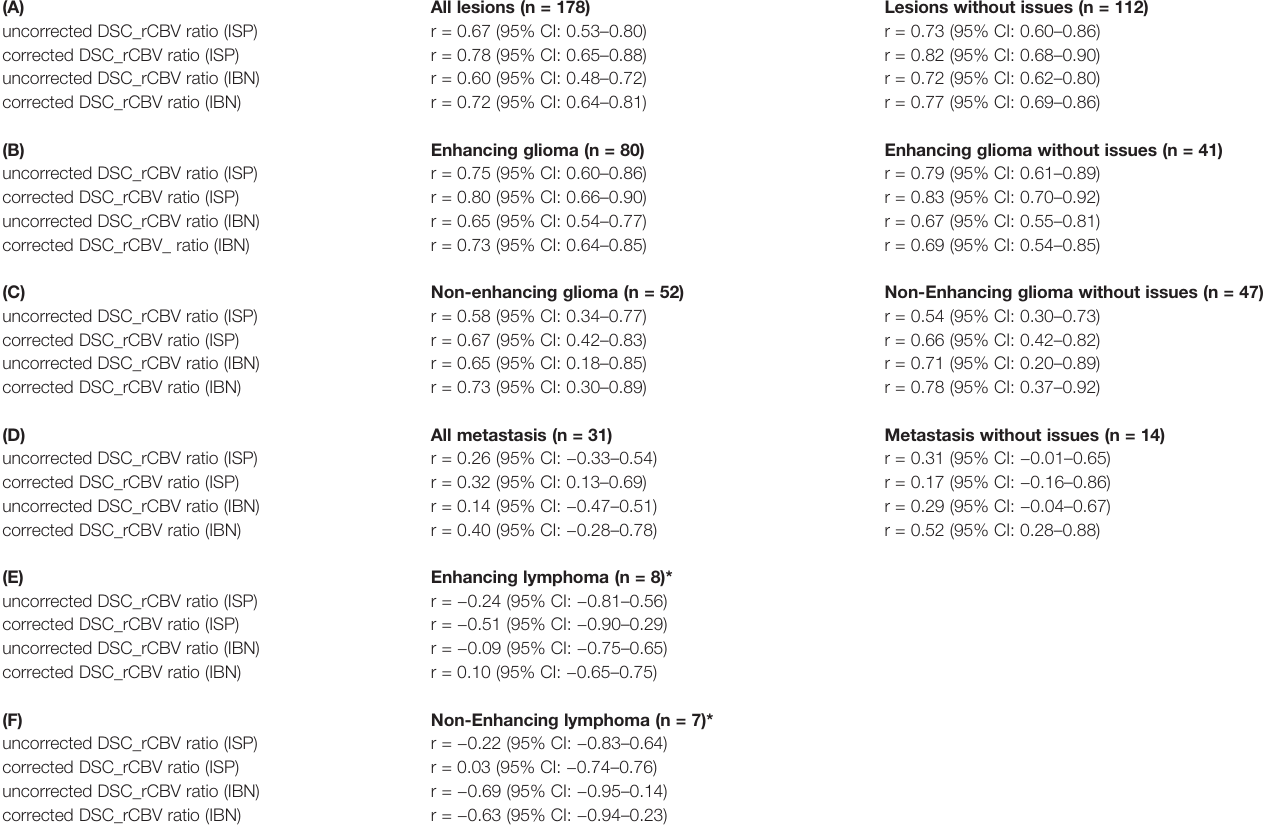
Correlation coef fi cients of all lesions (A) , subsets of enhancing glioma (B) , non-enhancing glioma (C) , metastasis (D) , enhancing lymphoma (E), and non-enhancing lymphoma (F) . Coef fi cients shown in the middle column are based on all lesions (with and without lesion speci fi c issues). Coef fi cients shown in the right column are based on subsets from which lesions with issues were excluded. *Because of the very small subset size of enhancing lymphoma and non-enhancing lymphoma (<10), cluster bootstrapping was not possible.